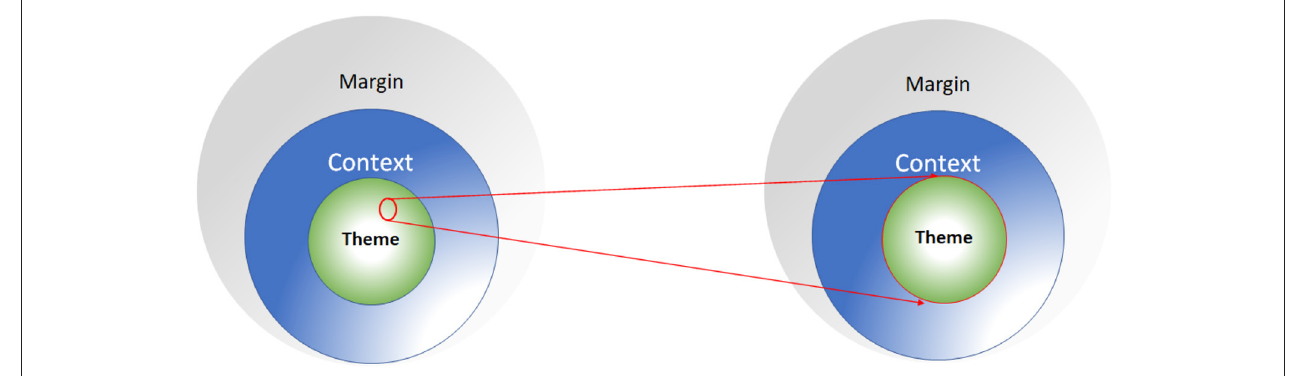
FIGURE 5 | Singling